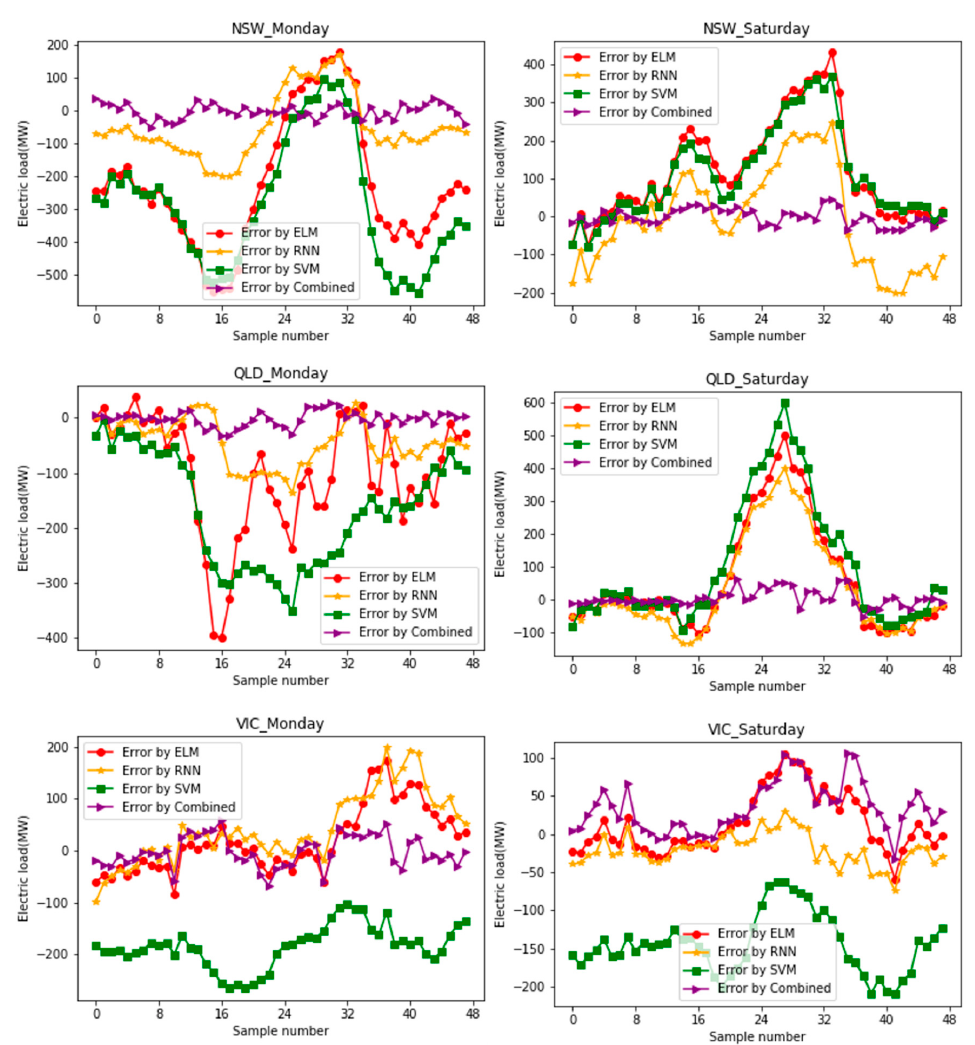
Figure 8. Comparison of the final forecasting errors of the four models on Monday and Saturday.